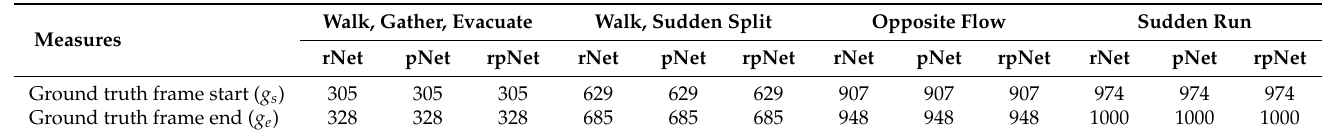
Table 2. Qualitative and quantitative analysis of the simulated normal and abnormal video events in Figure